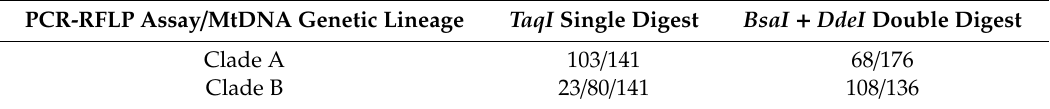
Table 3. Expected fragment sizes (bp) for two alternative PCR-RFLP assays that can be used to distinguish between two divergent genetic lineages of O. disjunctus based on initial PCR amplification of a 244-bp section of mtDNA COI (see Supplementary material, Figure S1). The single enzyme ( TaqI ) RFLP assay di ff erentiates clade A from clade B by cutting either once or twice, respectively. The double digest RFLP assay cuts once in all cases, but at di ff erent diagnostic DNA polymorphisms ( BsaI cuts clade A haplotypes, whereas DdeI cuts clade B